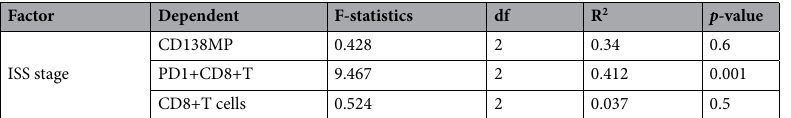
Factor Dependent F-statistics df R 2 p -value ISS stage